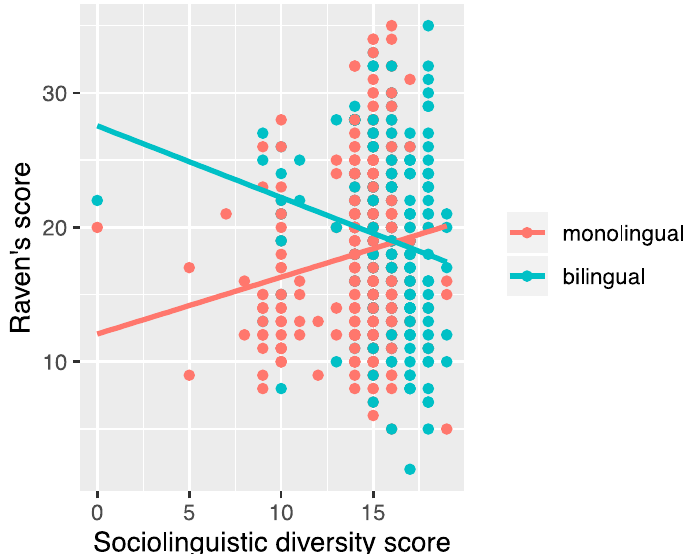
Figure 5. Visual representation of the interaction between sociolinguistic diversity and bilingualism on the Raven’s score.